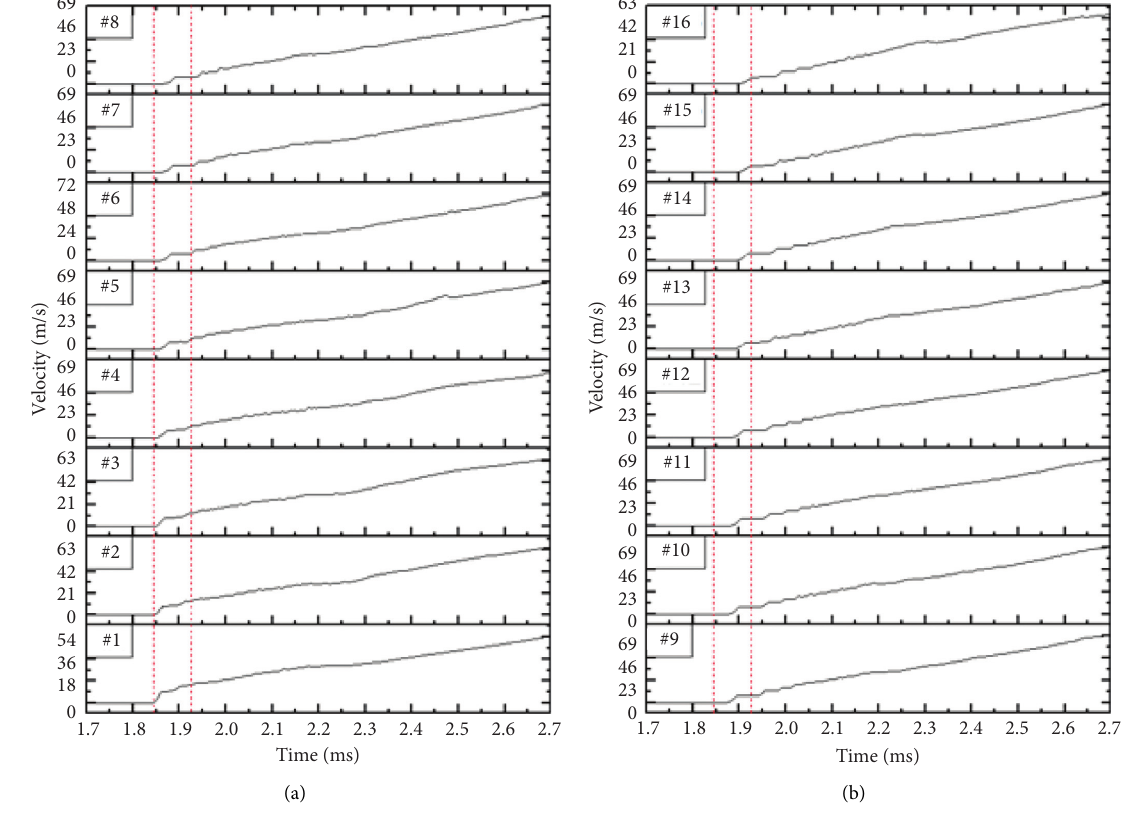
Figure 15: Particle velocity during the acceleration